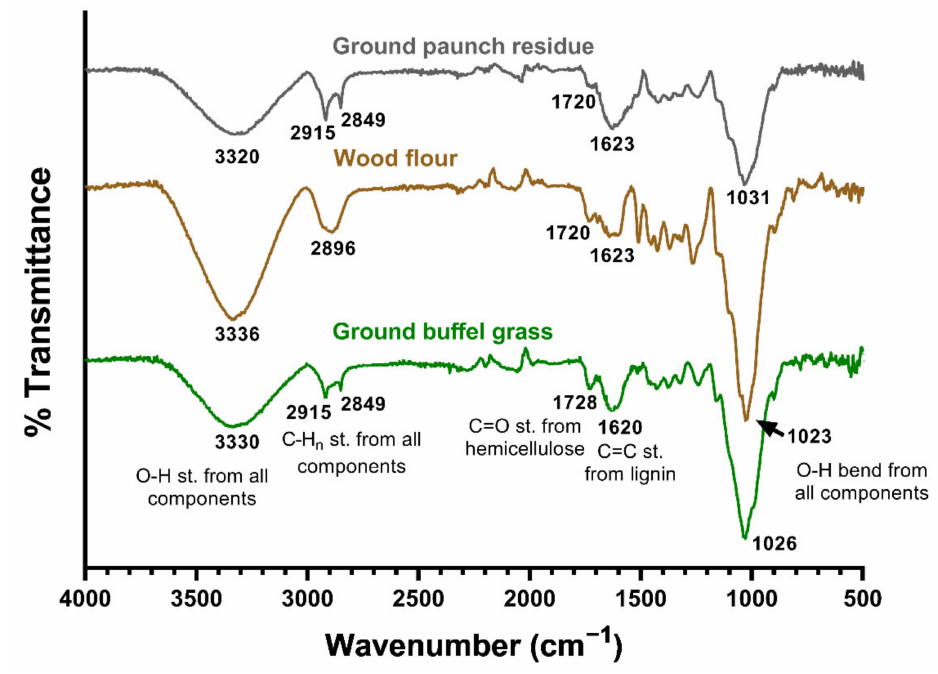
Figure 2. FT-IR spectra of ground paunch, wood flour and ground buffel grass.